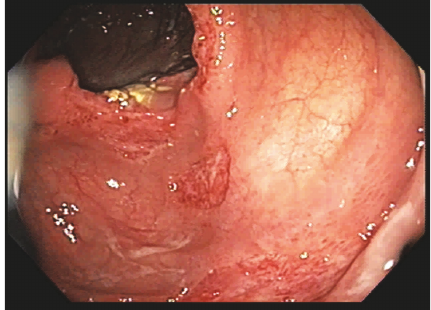
Figure 5: Pathologic specimen with confirmation of T. gondii by immunohistochemistry. Cystic forms are present alongside dis- persed tachyzoites. The arrows refer to toxoplasmosis cyst high- lighted by